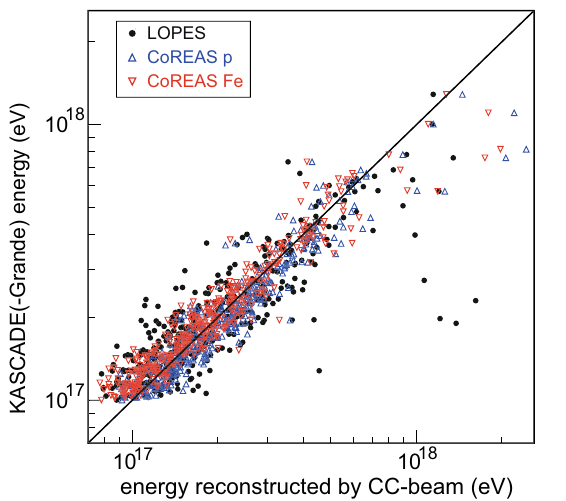
Fig. 16 Comparison of the energy reconstructed by the amplitude of the cross-correlation beam to the KASCADE(-Grande) energy for LOPES measurements and CoREAS simulations including noise. Left: Per-eventcomparison.Theoutliersintheupper-rightcornervisiblealso in the simulations have a small east-west component of the geomag-